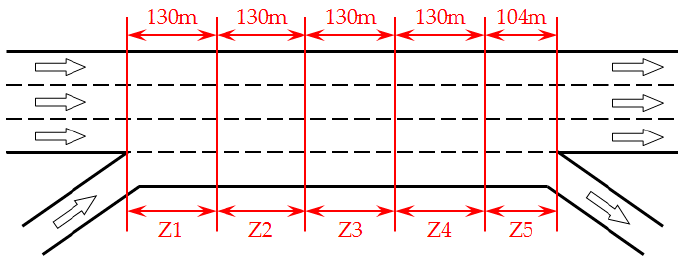
Figure 3. Division of the observed weaving section into five zones.